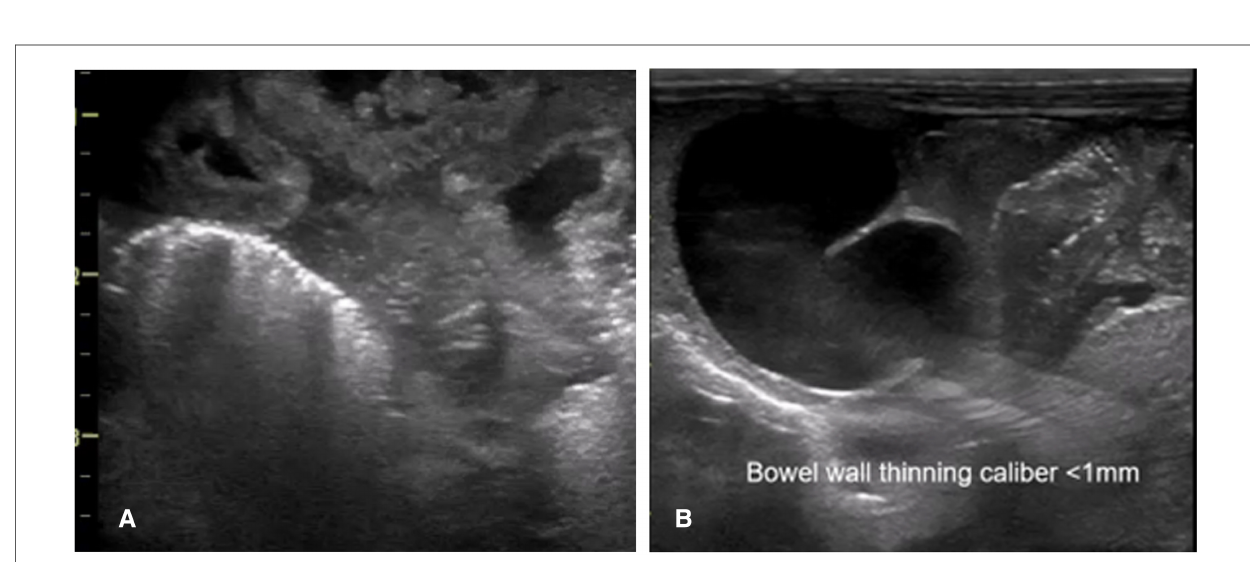
FIGURE 5 The sonographic appearance of the bowel wall during various stages of necrotizing enterocolitis on point-of-care abdominal ultrasound. ( A ) Bowel wall thickening. ( B ) Bowel wall